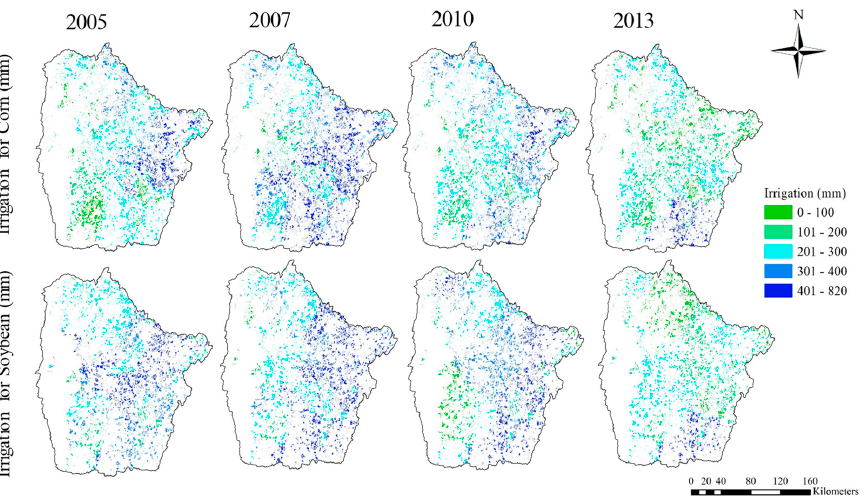
Figure 5. Simulated irrigation amount for corn and soybean production. Maps are presented for four dry years: 2005, 2007, 2010, and 2013.